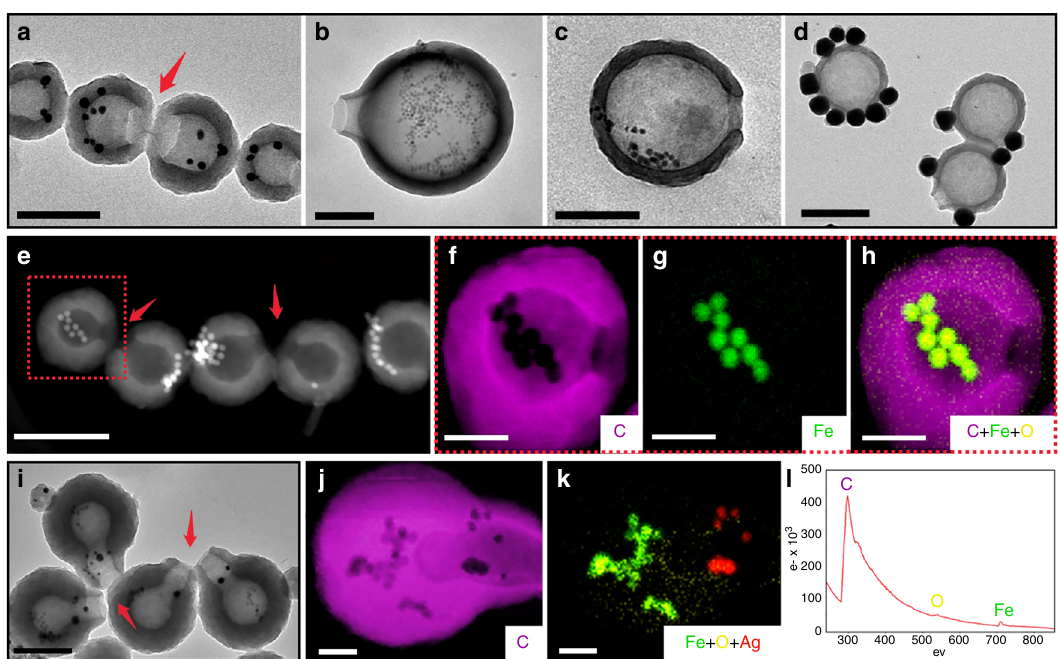
Fig. 6 C 60 multi-compartment nanocontainers. TEM images of a nanobowls holding Ag nanoparticles; b nanobottles holding Fe 3 O 4 nanoparticles; c nanobowls holding Co nanoparticles; d hydrophilic Au nanoparticles stay out of the nanobottles. e High-angle annular dark fi eld (HAADF) image of nanobowls holding Fe 3 O 4 nanoparticles, and its elemental mapping ( f – h ). i TEM image of multi-compartment nanocontainers with Fe 3 O 4 nanoparticles in the bottom node and Ag nanoparticles in the upper node, and its elemental mapping ( j , k ). l Electron energy loss spectroscopy (EELs) of nanobowls holding Fe 3 O 4 upper node. Scale bars are 200 nm for TEM images, and 50 nm for elemental mapping pro fi